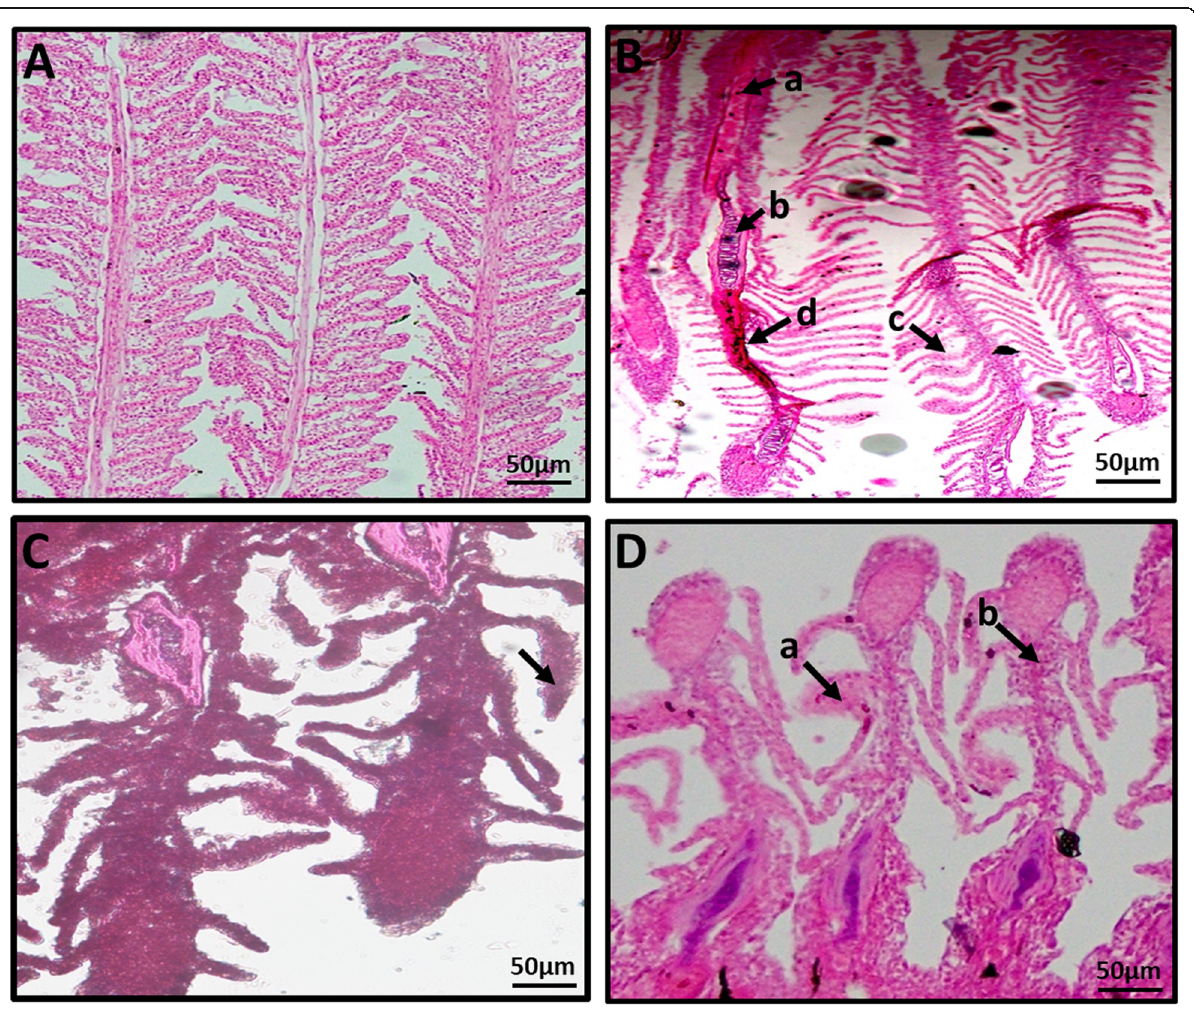
Fig. 2 Photomicrographs of gills of Heteropneustes fossilis after 7-day exposure to 0.015 ppm Envoy 50 SC. a Control — normal epithelial cell and secondary lamellae were found; b blood congestion (a), hyperplasia (b), curling of secondary lamellae (c), and hemorrhage (d); c epithelial hyperplasia; and d clubbing (a) and necrosis (b) were